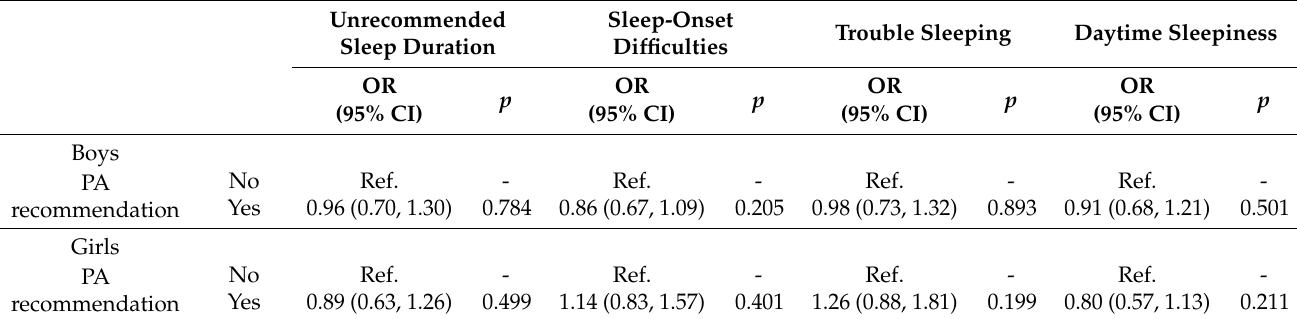
Table 3. Relationship between sleep difficulties and PA in adolescent boys and girls 1